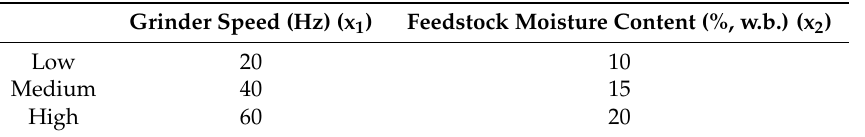
Table 1. The levels for the two factors.